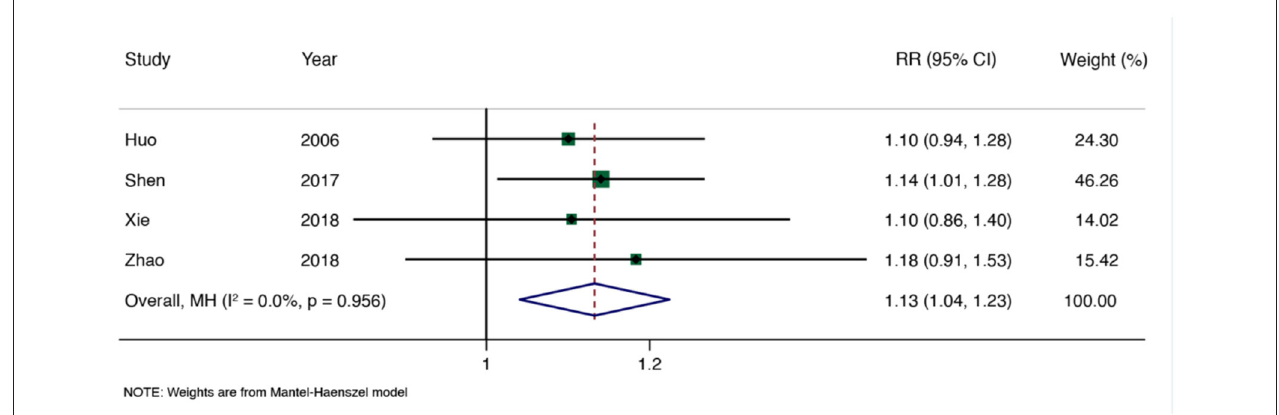
FIGURE 5 | Meta-analysis of total effectiveness rate (moxibustion combined treatment for